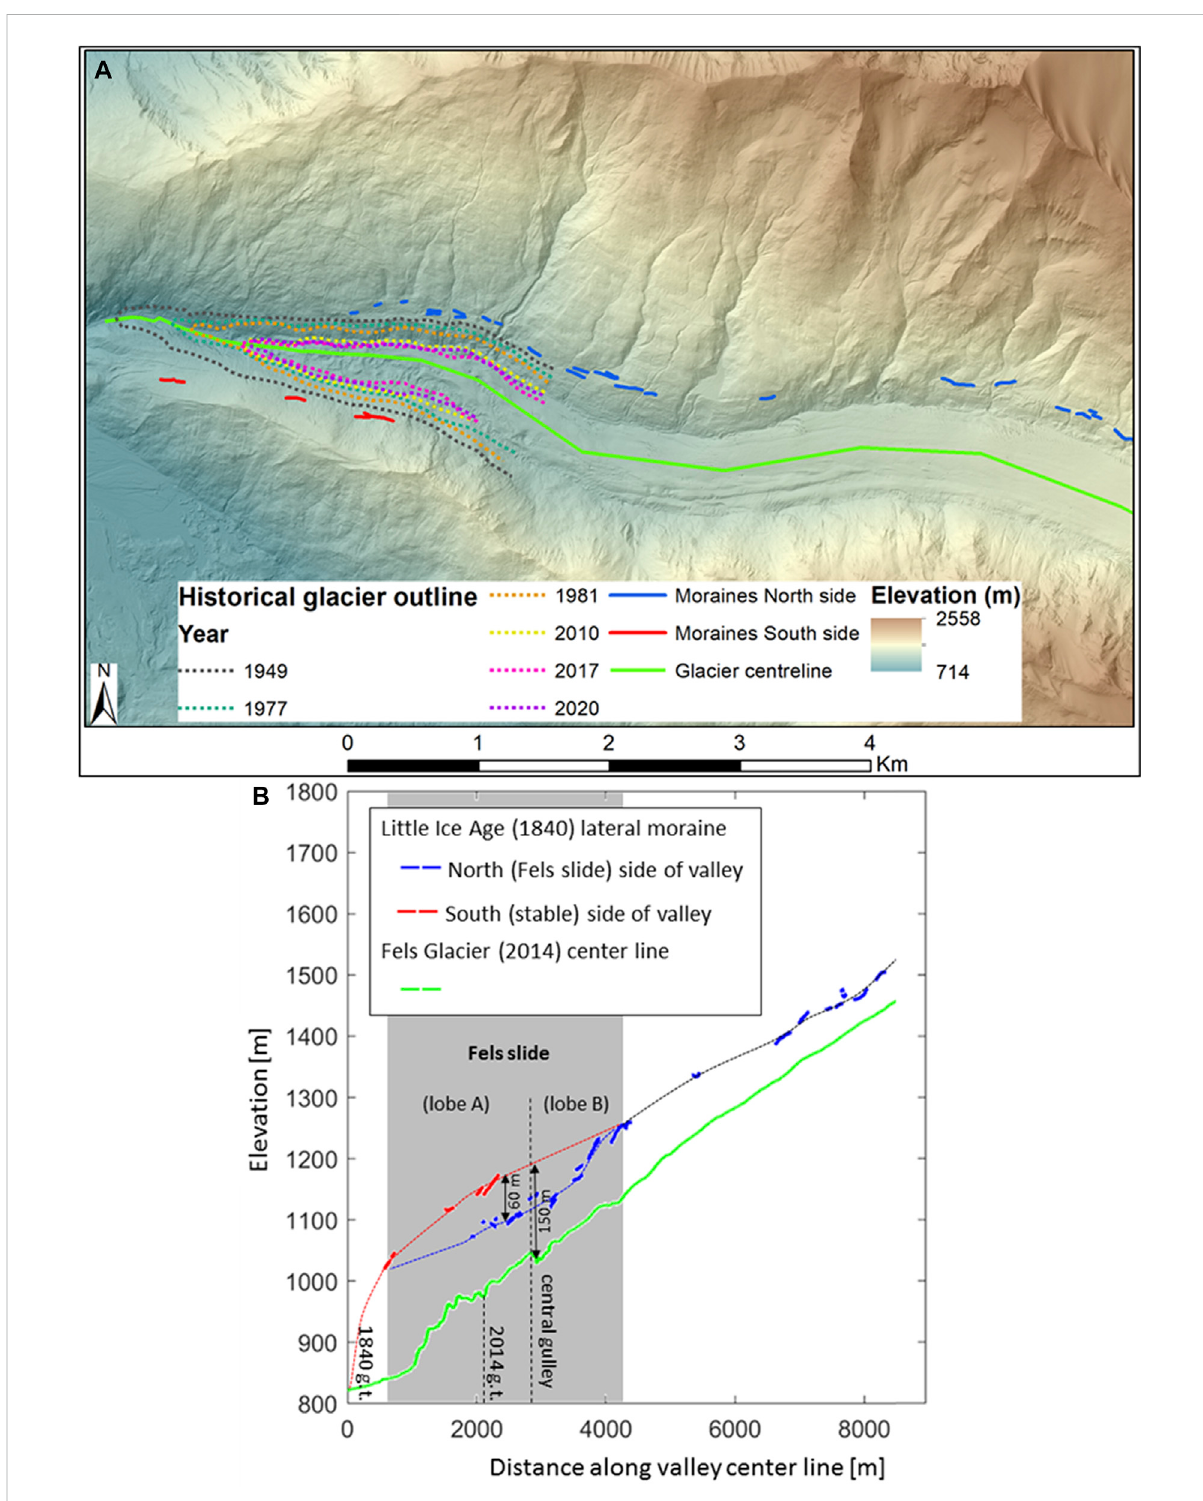
FIGURE 8 Long-term recession and downwasting of lower Fels Glacier inferred from Little Ice Age (LIA) moraines that stabilized around 1840. (A) Remnants of LIA maximummorainesinFelsvalley(redandbluelinesegments)superimposedonaLiDAR-derivedtopographicmap.Theoutlinesoftheglacierterminus,derivedfrom aerial photography, are shown for different years. (B) Elevation of the Fels valley center line (green line, extracted from the 2014 Lidar DEM) and elevations of the